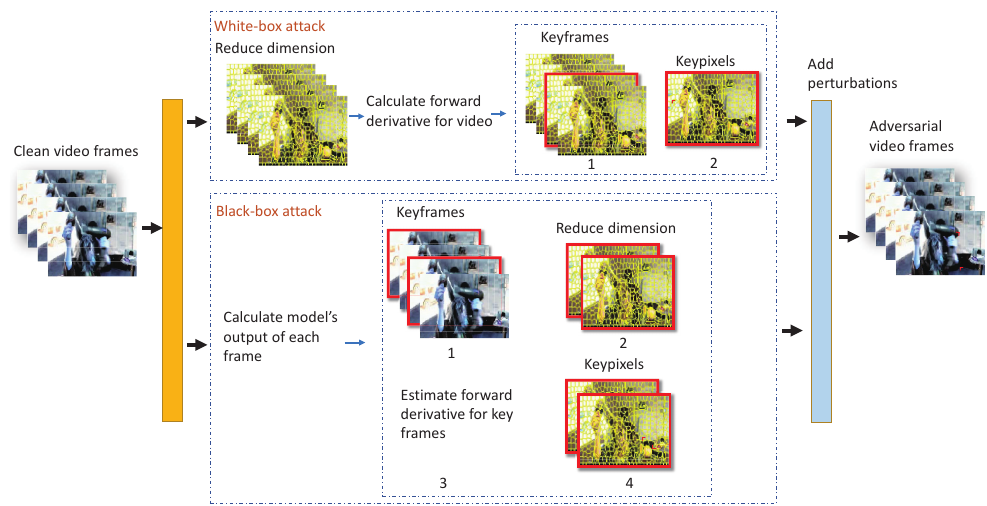
Figure 2. The overall framework. We illustrate the frameworks in the white-box attacks and black-box attacks, respectively. The top part is the white-box attack pipeline and the bottom part is the black-box attack